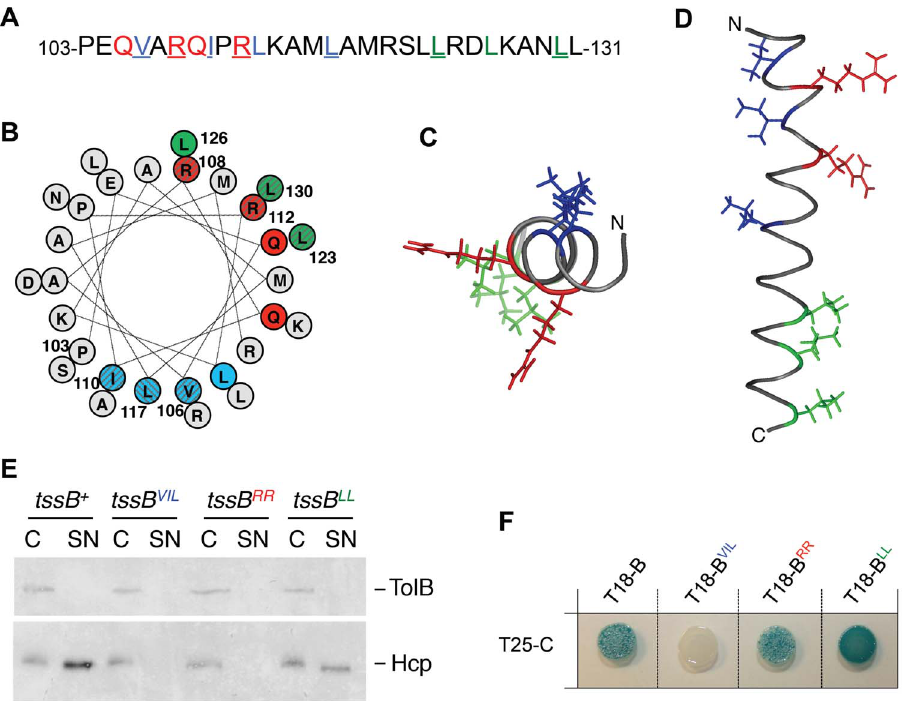
Figure 3. The hydrophobic motif of the TssB1 a -helix is required for T6SS function and interaction with TssC1. Amino-acid sequence (A) and helical wheel projection (B) of the TssB1 a -helix (from residue Pro-103 to residue Leu-131). The different motifs described in this study are highlighted in different colours: blue, N-terminal hydrophobic; red, polar/charged; green, leucine-rich. The residues of these motifs mutagenized in this study are underlined (A) or striped (B). Top-view (C) and side-view (D) projections of the TssB1 a -helix. The targeted residues are colored as in panel (A). Top- and side-views have been modelled using PyMOL v0.99. (E) Hcp release assay. Hcp FLAG release was assessed by separating whole cells (C) and culture supernatant (SN) fractions from 2 6 10 9 D tssB1 cells producing TssB1 ( tssB + ) or TssB1 bearing substitutions within the hydrophobic ( tssB VIL ), the polar/charged ( tssB RR ) or the leucin-rich ( tssB LL ) motif. Proteins were separated by 12.5%-acrylamide SDS-PAGE and Hcp and TolB were immunodetected using anti-FLAG monoclonal (lower panel) and anti-TolB polyclonal (upper panel) antibodies. (F) Bacterial two-hybrid assay. BTH101 reporter cells producing the T25 domain of the Bordetella adenylate cyclase fused to TssC1 (T25-C) and the T18 domain fused to TssB1 (T18-B) or TssB1 variants bearing substitutions within the hydrophobic (T18-B VIL ), the polar/charged (T18-B RR ) or the leucin-rich (T18-B LL ) motif were spotted on X-Gal indicator LB agar plates.